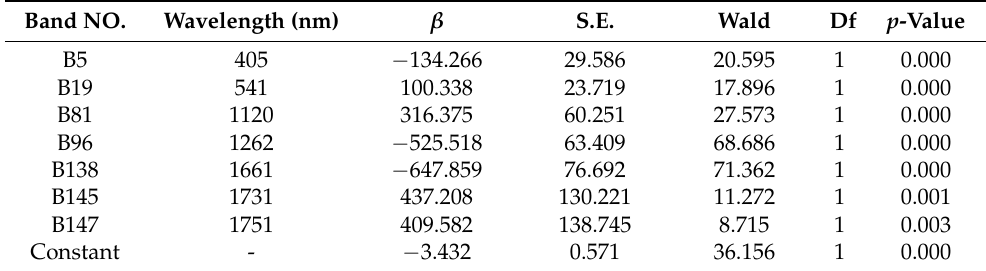
Table 3. HRI logistic model parameters derived from BLR and Wald